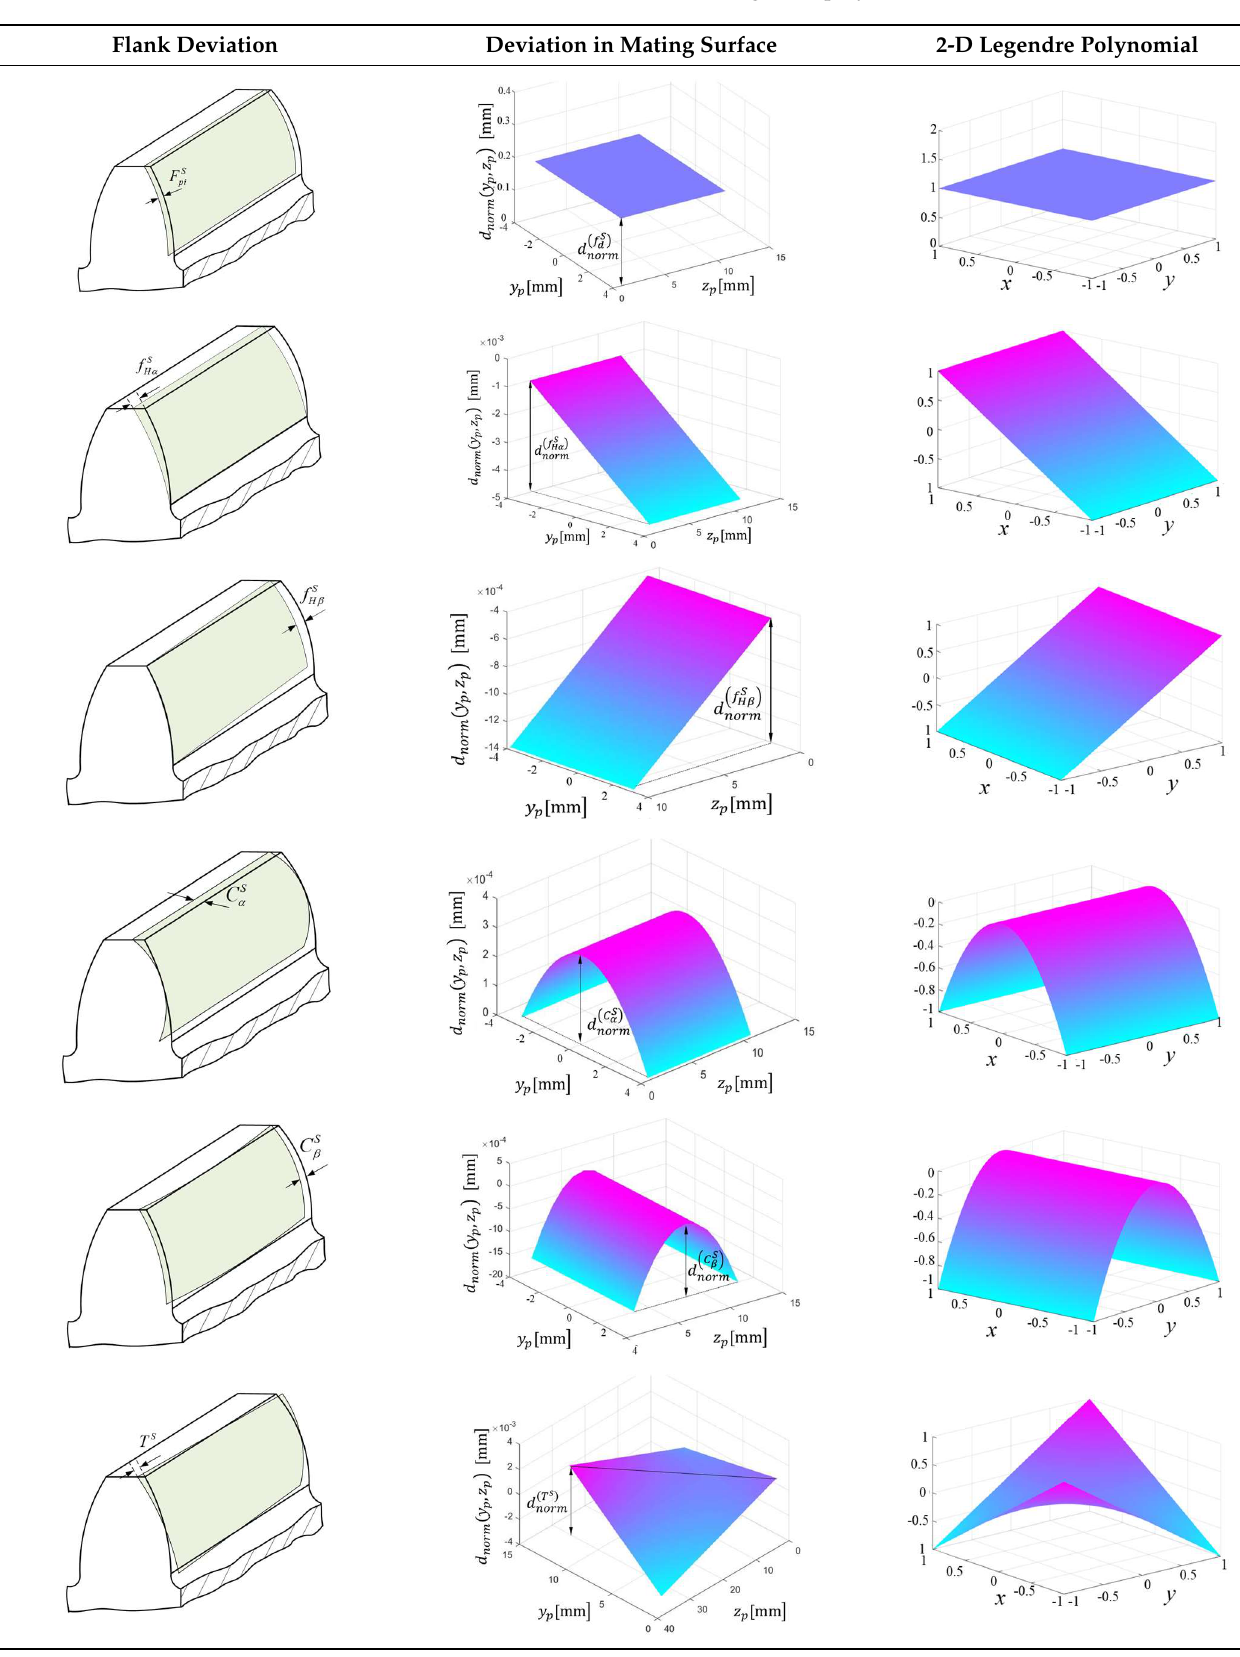
Table 1. Deviations of tooth flank and 2-D Legendre polynomials characterization. Flank Deviation Deviation in Mating Surface